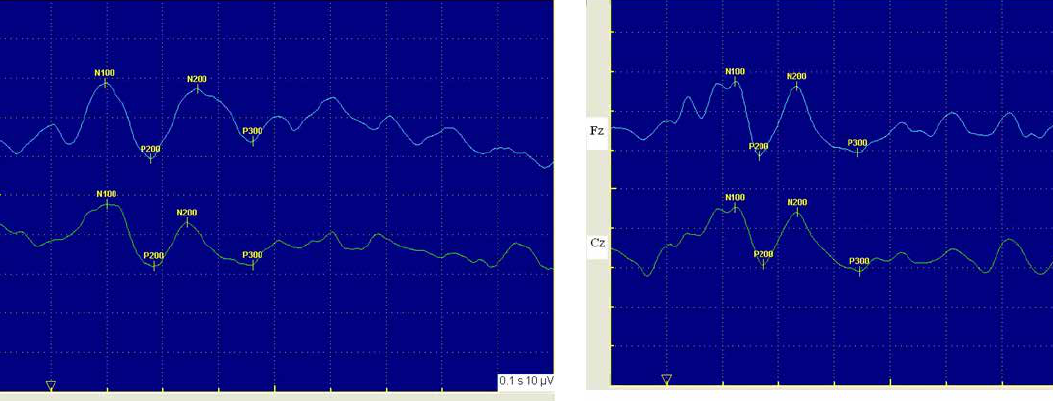
Figure 1: P300 response of a patient with a longer latency and a Figure 2: P300 response of a healthy male lower amplitude Table 1 : Comparison of demographics and P300 amplitude and latencies in both groups Patient n=17 Control